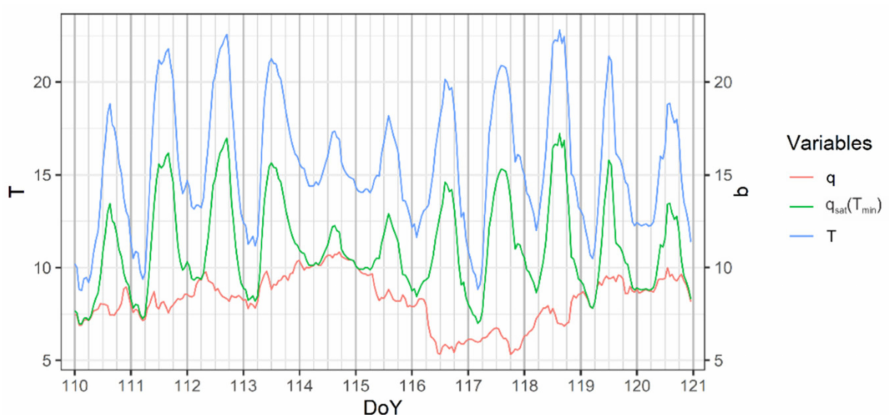
Figure 6. Daily variation of hourly air temperature ( T ( ◦ C)), specific humidity ( q (g kg − 1 )) and saturated specific humidity ( q sat ( T min ) (g kg − 1 )) in NS/CE orchard for DOY 110–121 in 2014.